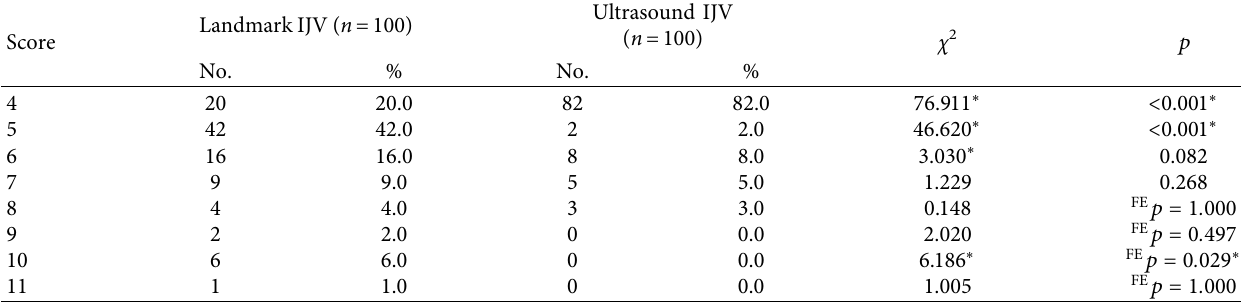
Table 1: Group (A): comparison between landmark and ultrasound (IJV) techniques according to our scoring system. Score